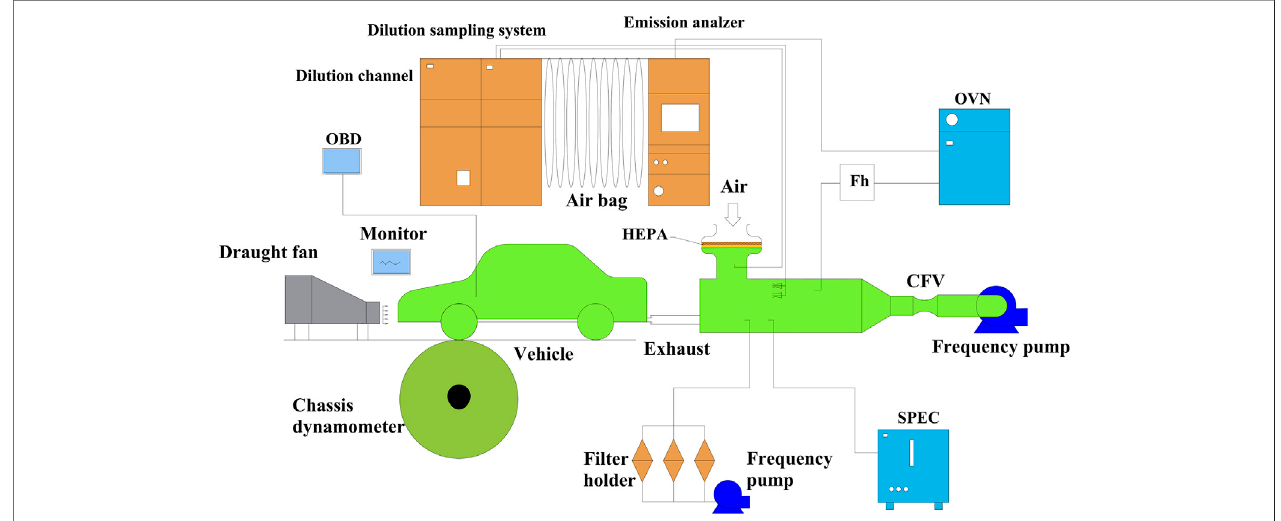
FIGURE1| Schematicoftherotatingdrumtestbench(Liuetal.,2019).OVN:oventypeheatedanalyzer;HEPA:highef fi ciencyparticulateair fi lter;CFV:critical fl ow